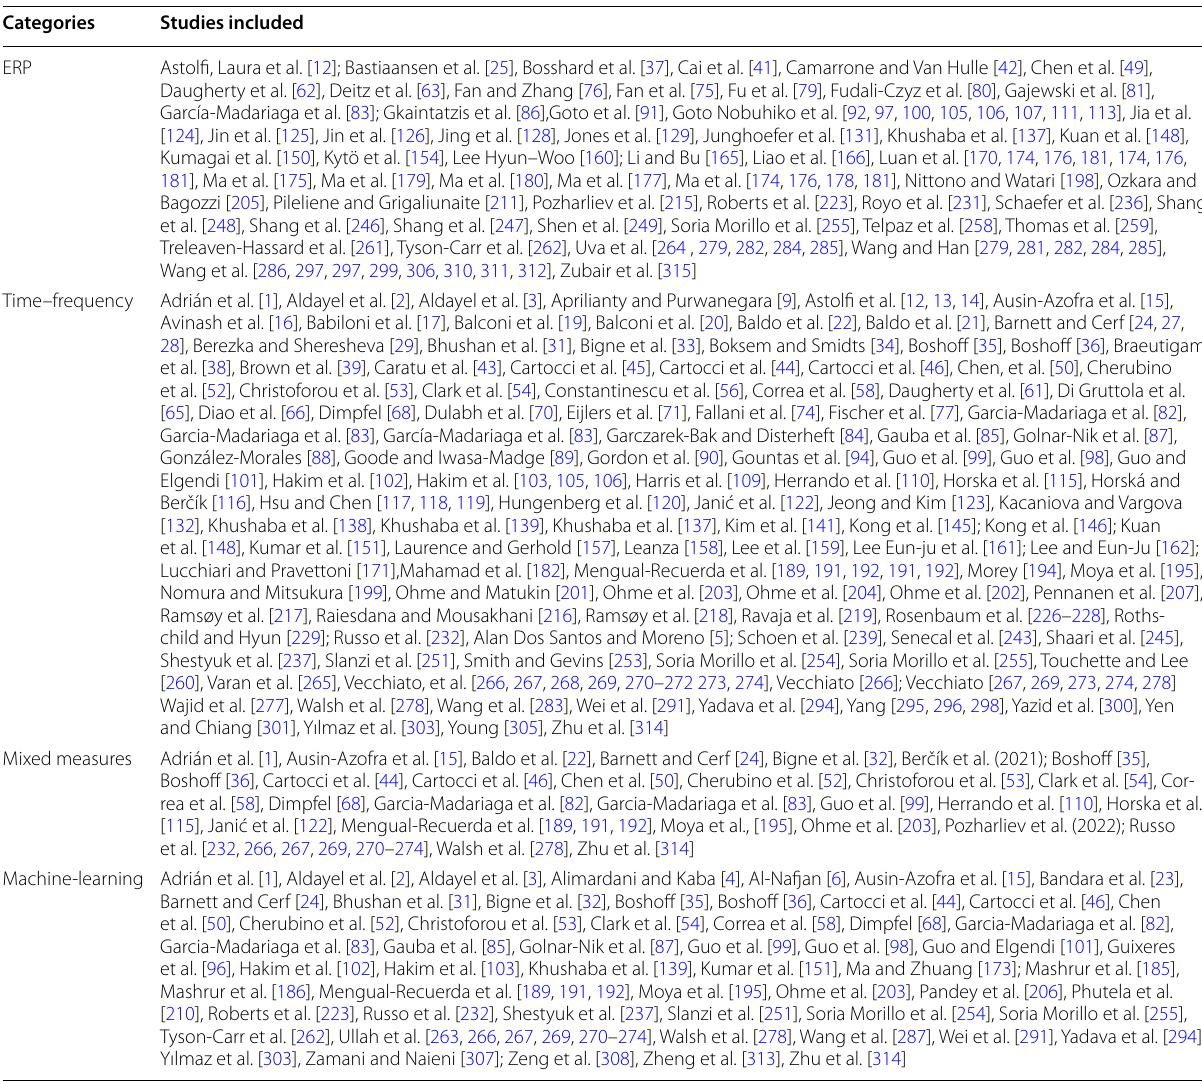
Table 3 A summary of papers included in the current subset of the systematic review, categorised according to the measures